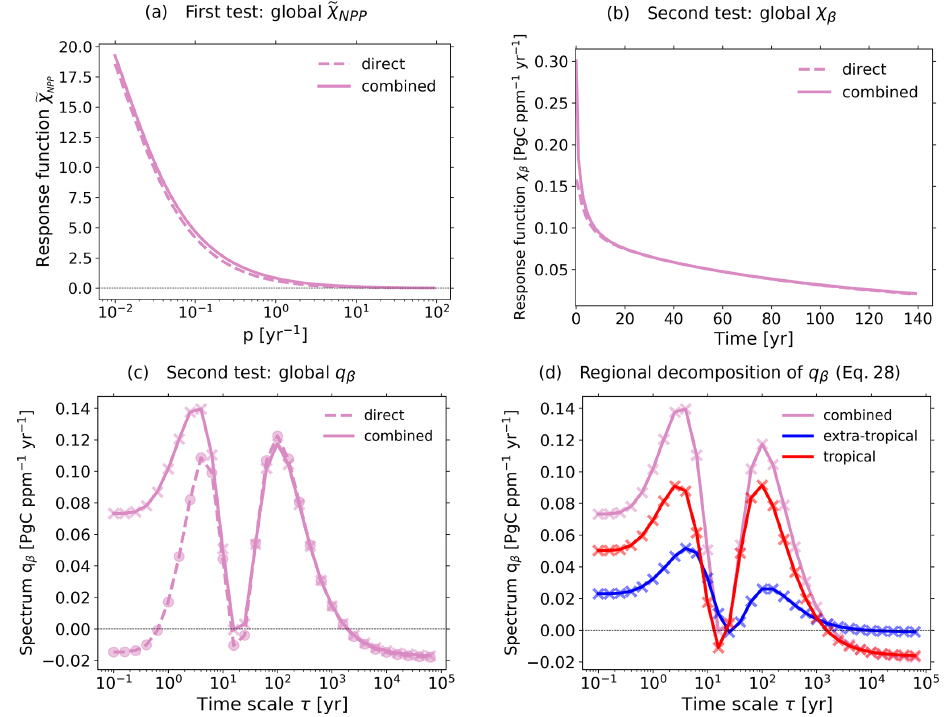
Figure 10. Investigation of the land carbon response in the tropics and extra-tropics and how the regional response functions combine to the global response functions. The analysis is based on the 2 × CO 2 bgc experiment. (a) Laplace transform (cid:101) χ NPP (p) of global χ NPP (t) obtained directly from the global carbon response and from combining the tropical and extra-tropical response functions; (b) χ β (t) obtained directly from the global carbon response and from combining the tropical and extra-tropical response functions; (c) as (b) but for q β (τ) ; (d) decomposition of q β (τ) into tropical and extra-tropical spectra (Eq. 31). In (c, d) the dots and crosses indicate the computed values, while the connecting lines are only inserted to guide the eye. For more details, see